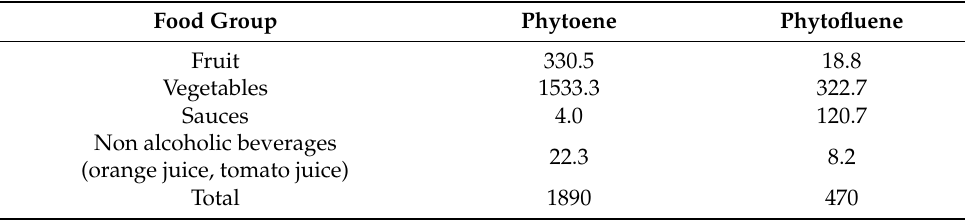
Table 2. Daily PT and PTF intake ( µ g/person/d) from the different food groups in the Spanish adult population.